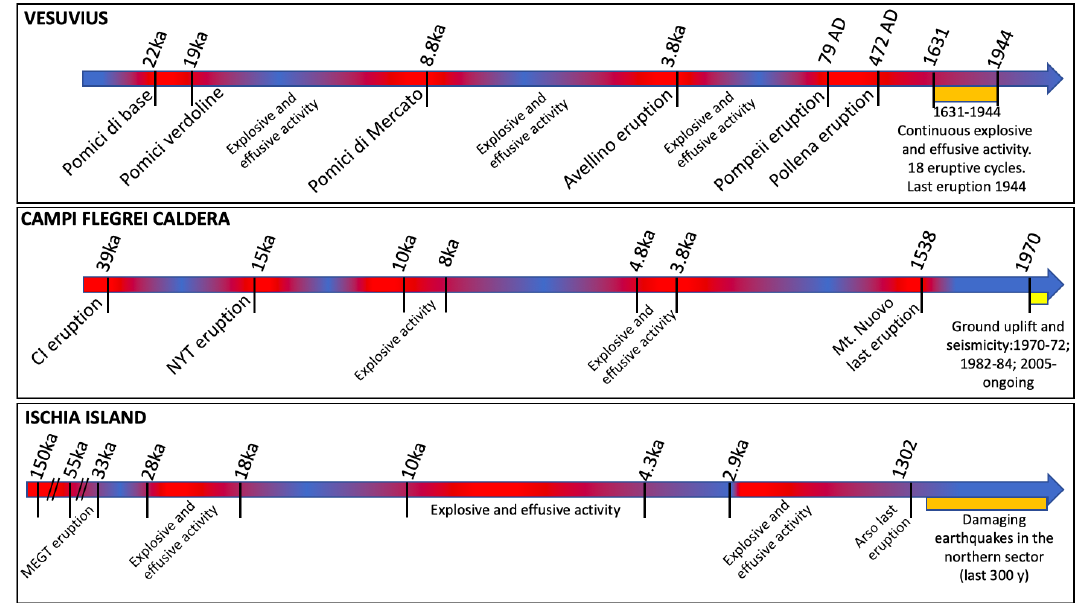
Figure 2. A timeline of volcanic activity history at Vesuvius, Campi Flegrei and Ischia island. The most important eruptions are reported. Red and blue colours indicate increasing and decreasing volcanic activity, respectively (after Piochi et al.,